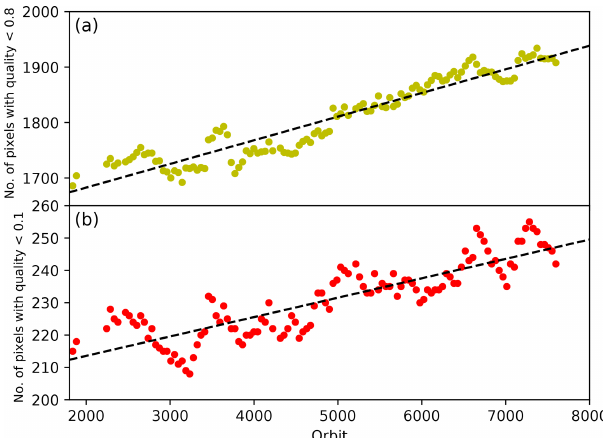
Figure 22. Number of bad (quality < 0 . 8, a , yellow dots) and dead (quality < 0 . 1, b , red dots) detector pixels since March 2018. A linear fit is shown using a black dashed line for each type. These have slopes of 42 and 6 detector pixels per 1000 orbits for bad and dead detector pixels respectively.